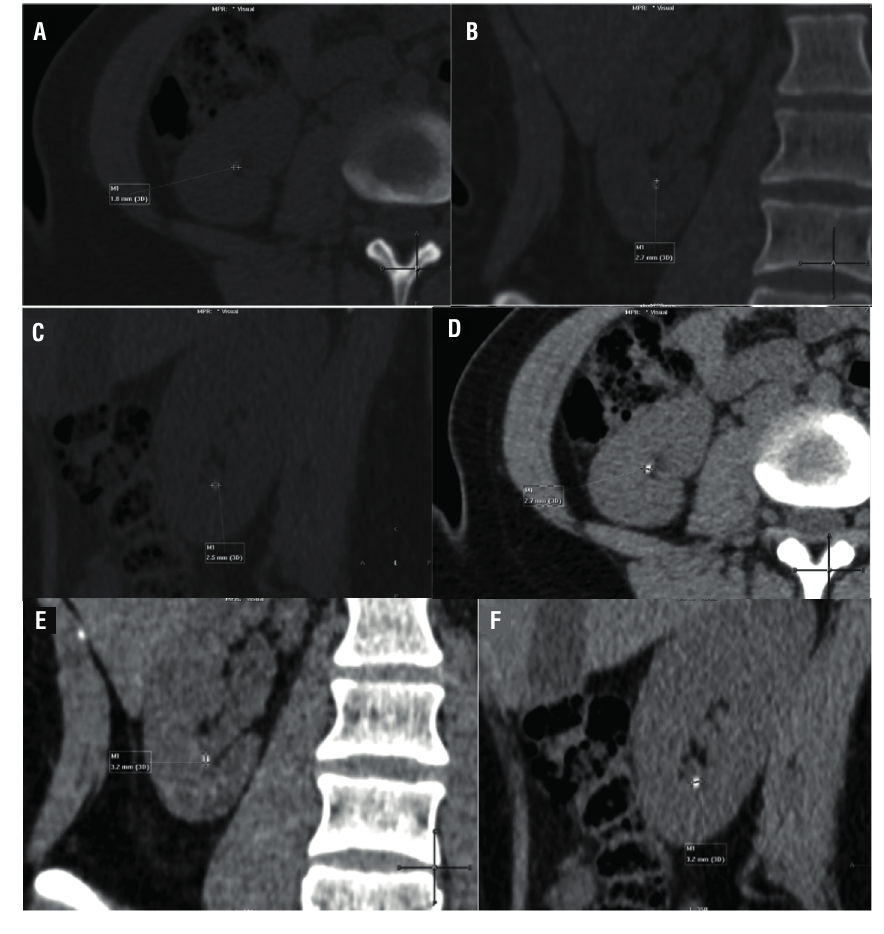
Figure 2 - Postoperative magnified (400%) NCCT bone window (ww 1600HU/wl 500HU) vs. soft tissue window (ww 400HU/ wl 40HU). A) bone window axial stone diameter, B) bone window coronal stone diameter, C) bone window sagittal stone